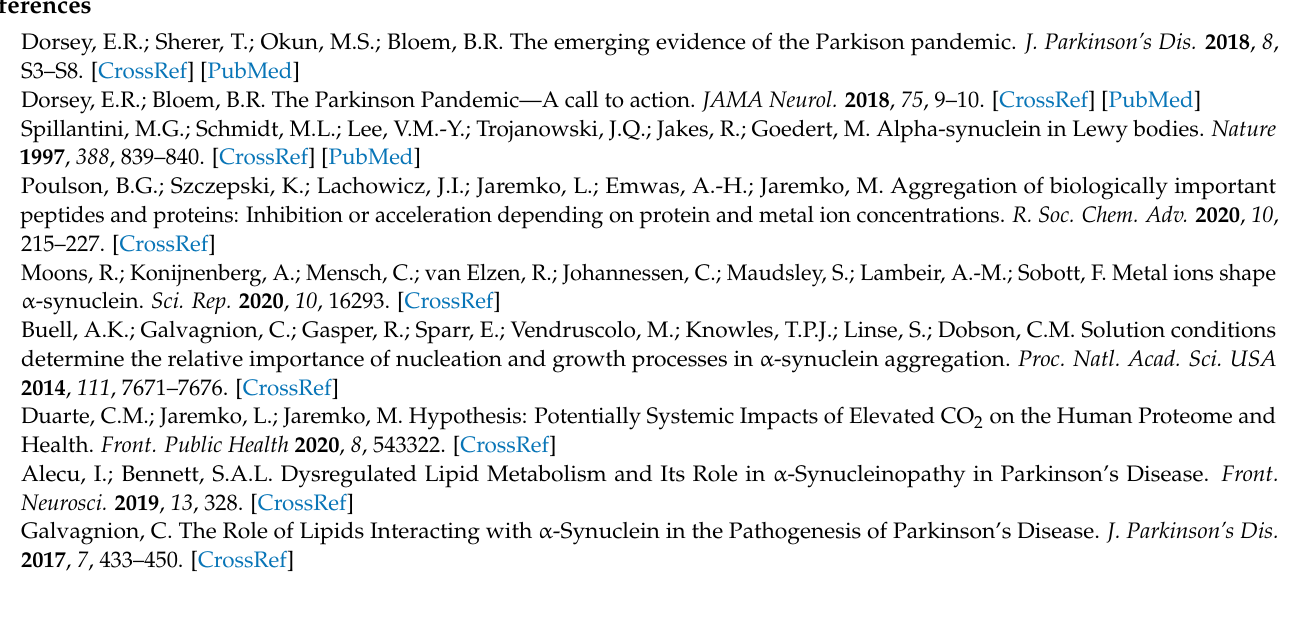
Figure S3: The effect of Ambroxol on lifespan; Figure S4: The effect of Ambroxol on α -synuclein aggregates; Figure S5: A DMSO dose response on thrashing and α -synuclein aggregates; Table S1: Description of the mean and maximal lifespan of wild-type and worms expressing the α -synuclein and associated counting in